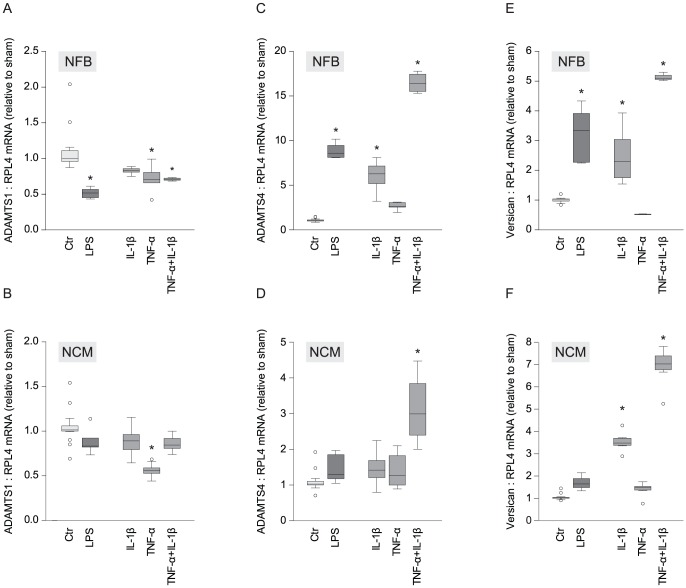
ADAMTS4 and versican mRNA in cardiac fibroblasts and cardiomyocytes was induced by inflammatory mediators.mRNA in NFB and NCM of ADAMTS1 (A,B), ADAMTS4 (C,D), and versican (E,F) after stimulation with LPS (n = 6), IL-1β (n = 7), TNF-α (n = 10 (NCM)/6 (NFB)), separate and combined (n = 7 (NCM)/4 (NFB)). Untreated cells served as control (n = 15 (NCM)/18 (NFB)). Box-plots show median (horizontal line), interquartile range (box), 1.5xinterquartile range or maximum/minimum range (whiskers) and outliers (>1.5xinterquartile range). *p<0.05, compared to control. NFB, neonatal fibroblasts; NCM, neonatal cardiomyocytes; LPS, lipopolysaccharide; IL, interleukin; TNF, tumor necrosis factor.